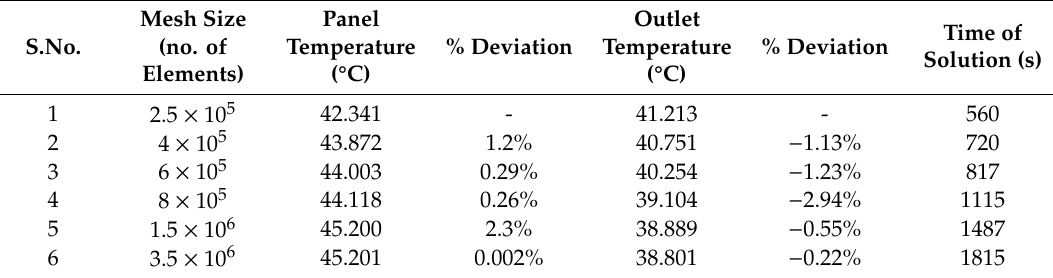
( b ) Figure 5. ( a ) Mesh along the thickness of panel. ( b ) Mesh inside and outside the tube. Table 5. Grid independence test S.No.